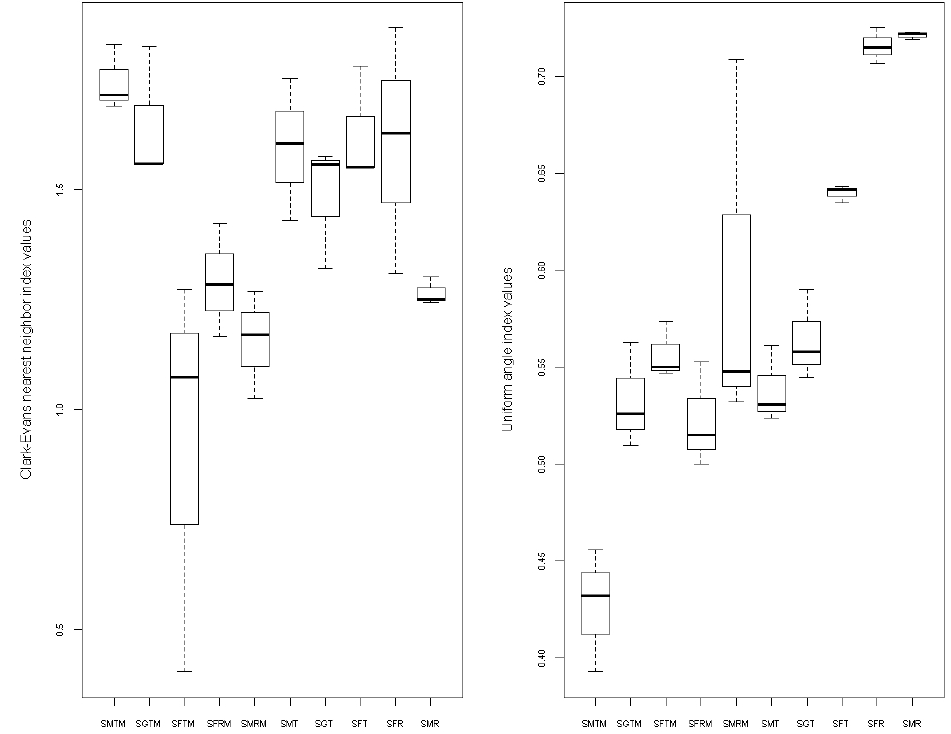
Figure 6. Clark-Evans nearest neighbors index and uniform angle index.